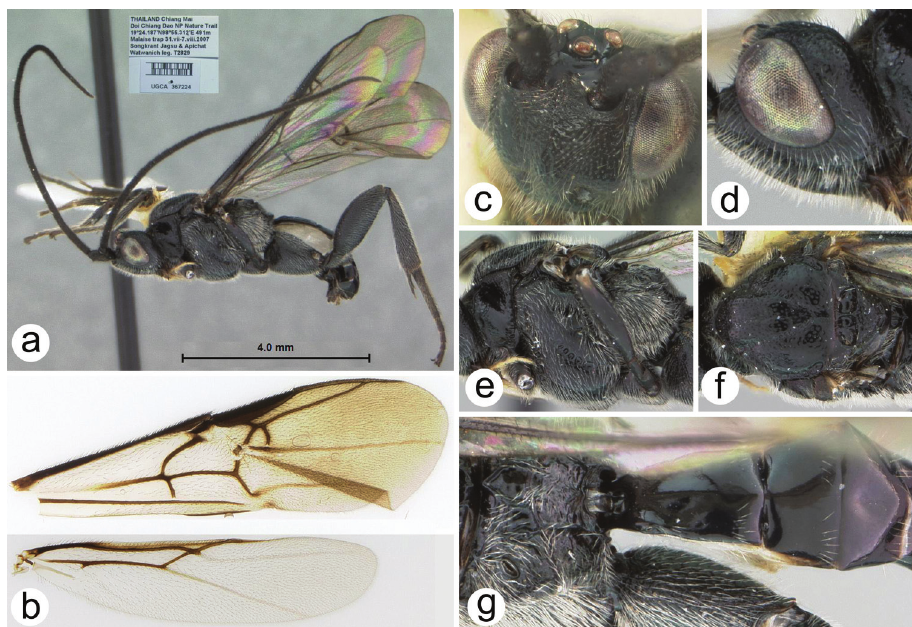
Figure 5. Zelodia cholathorni sp.n. a lateral habitus b wings c anterodorsal head d lateral head e lateral mesosoma f dorsal mesosoma g dorsal propodeum and